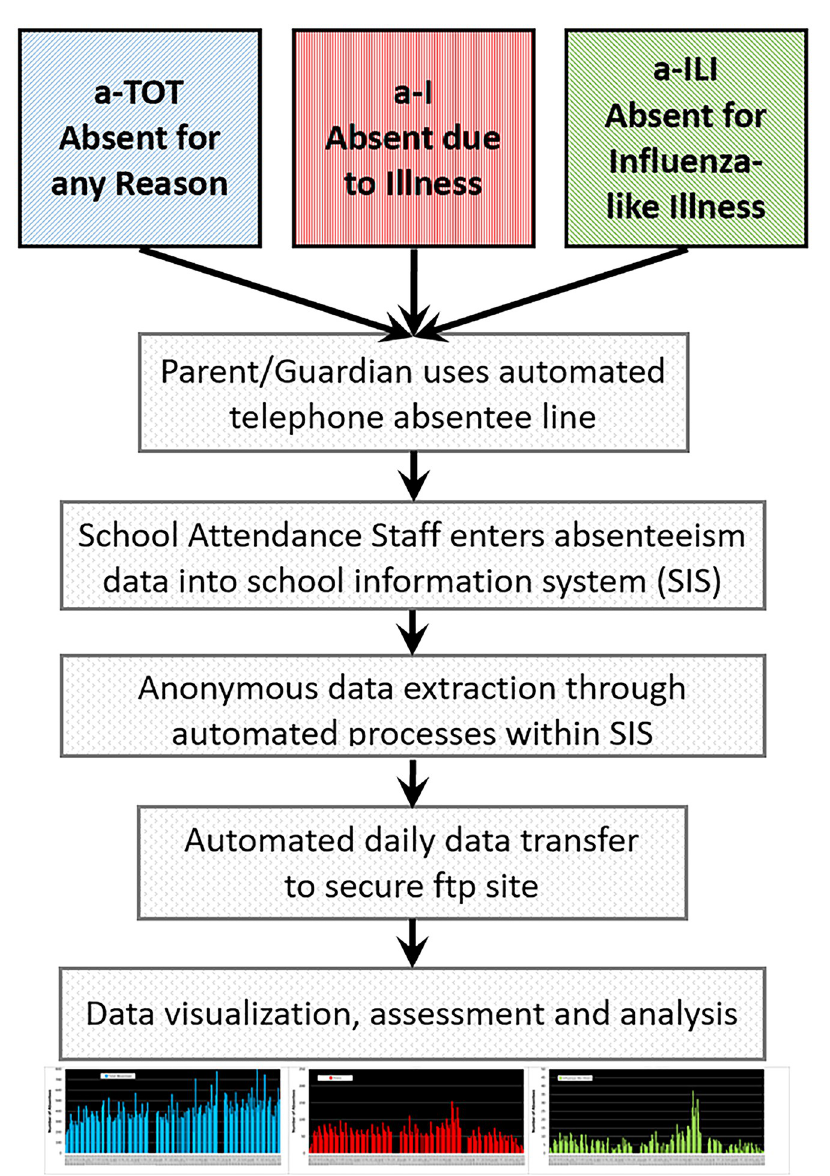
Fig 1. Flow diagram of absenteeism data from telephone reporting by parents/guardians, to entry into the student information system at the Oregon School District, to data transfer to the ORCHARDS research team.